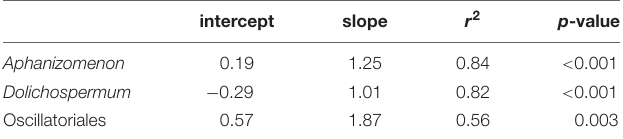
TABLE 3 | The intercept and slope of the orthogonal regression and the r 2 and p -value of the Pearson’s Correlation Coefficient from the comparison of biomasses acquired utilizing the IFCB and light microscopy. intercept slope r 2 p